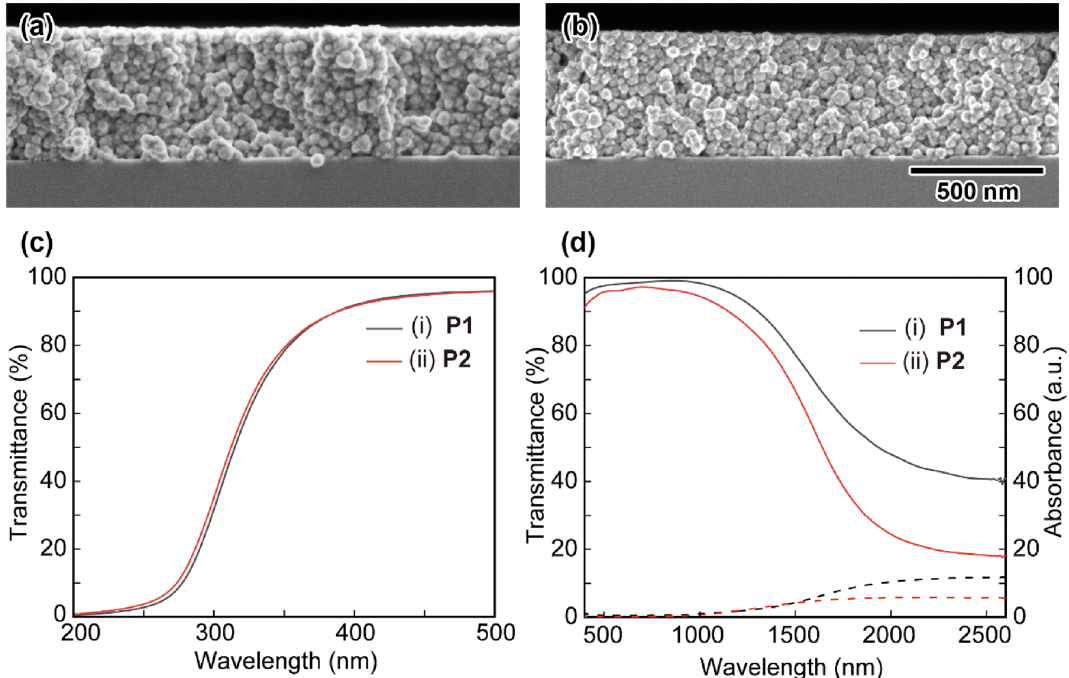
Figure 8. Cross-section SEM images of the ( a ) P1 - and ( b ) P2 -based ITO thin films on silicon substrates obtained by the NP-mist deposition method. The scale bar shown in ( b ) is common to ( a ). ( c ) Transmittance and ( d ) UV-NIR spectra of the (i) P1 - and (ii) P2 -based ITO thin films on glass substrates. Solid lines: transmittance; dashed lines: